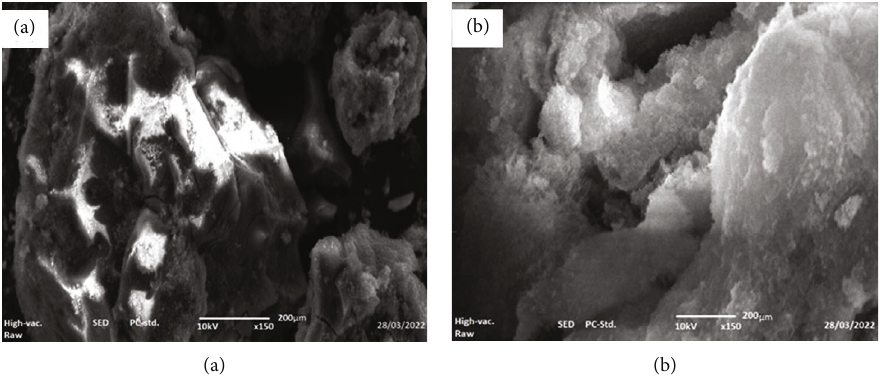
Figure 4: Scanning electron microscope (SEM) imaging for before (a) and after (b) bioadsorption at 200 μ m.